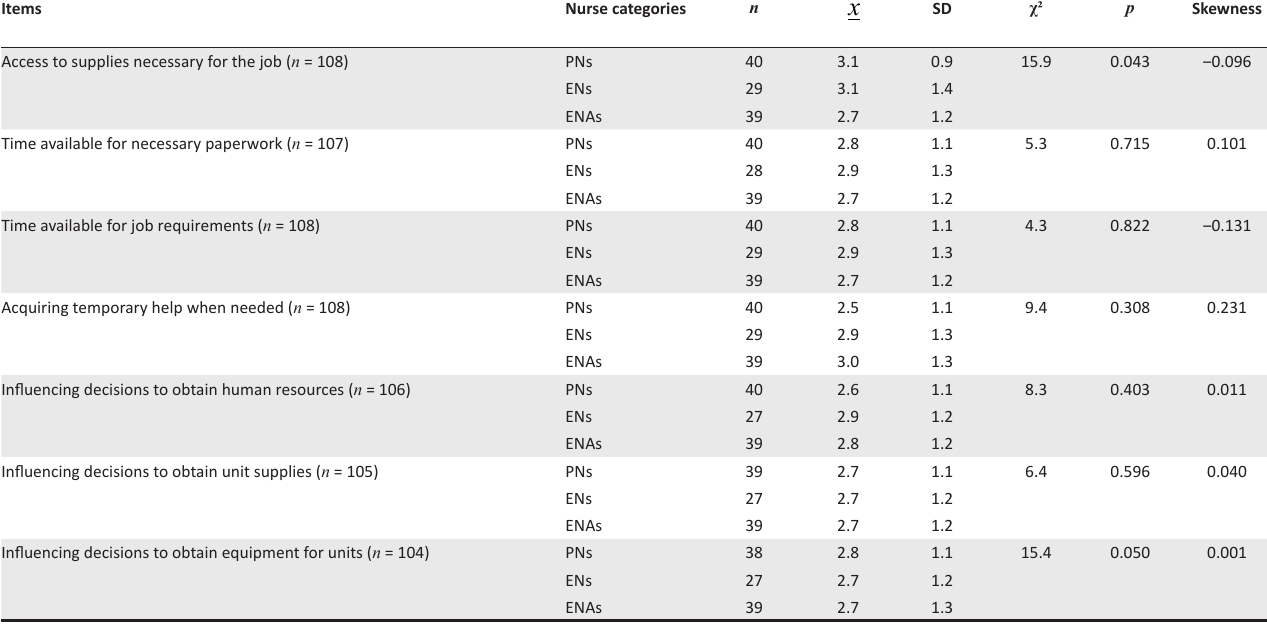
TABLE 4: Items on access to resources as a source of power for structural empowerment. Items Nurse categories n SD χ² p